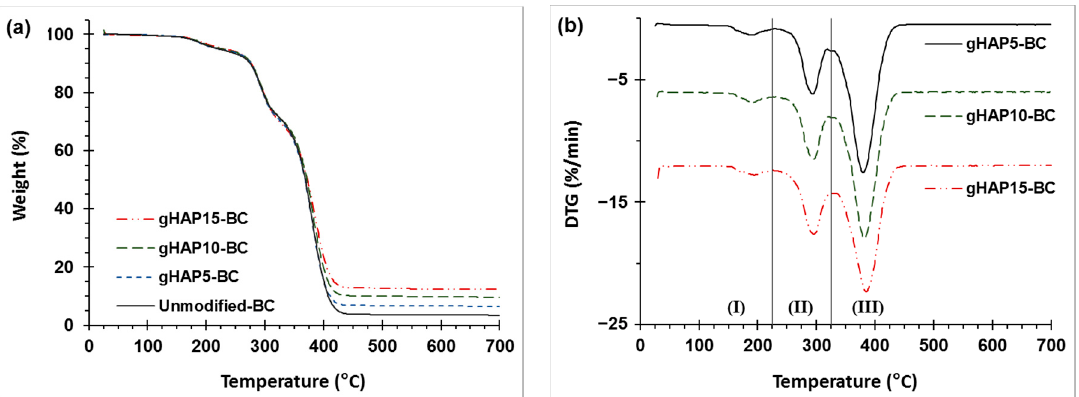
Figure 15. ( a ): TG and ( b ): DTG curves of PMMA bone cements modified with gHAP loadings of 0, 5, 10 and 15 wt.%. Note: (unmodified-BC: 0 wt.% of HAP, with 5 wt.% of ZrO 2 ).